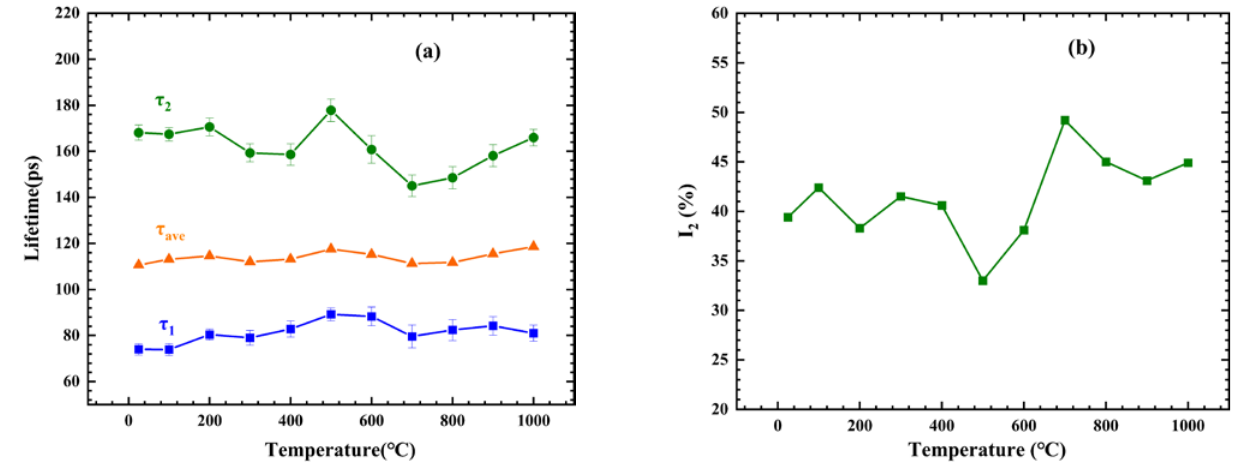
Figure 3. ( a ) Positron annihilation lifetime τ 1 , τ 2 , and average positron lifetime τ ave values; ( b ) the I 2 intensity trapped at vacancies at different annealing temperatures.